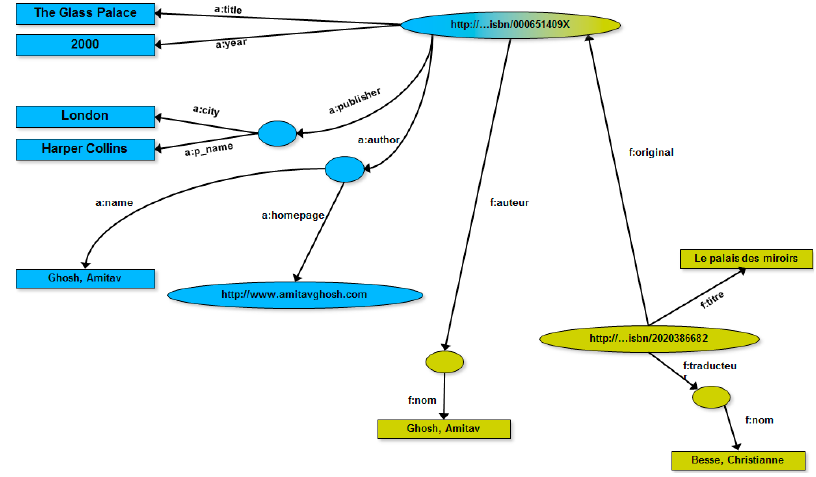
Figure 4. RDF graph obtained via integrating the two RDF graphs of Figure 3 [41].